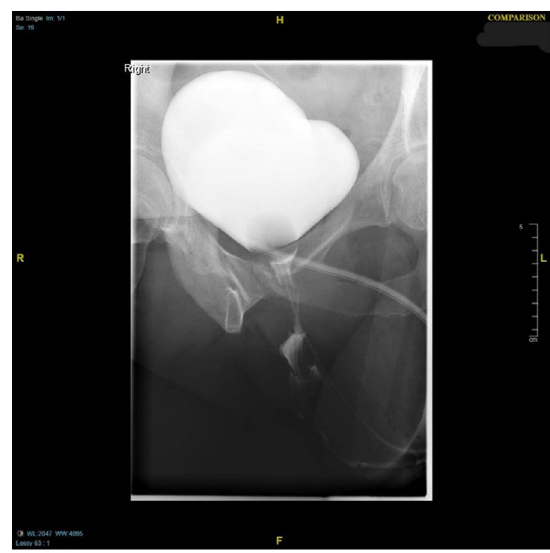
Fig. 3 Voiding phase pre-operative video-urodynamics Fig. 4 Post-operative urethrogram – voiding